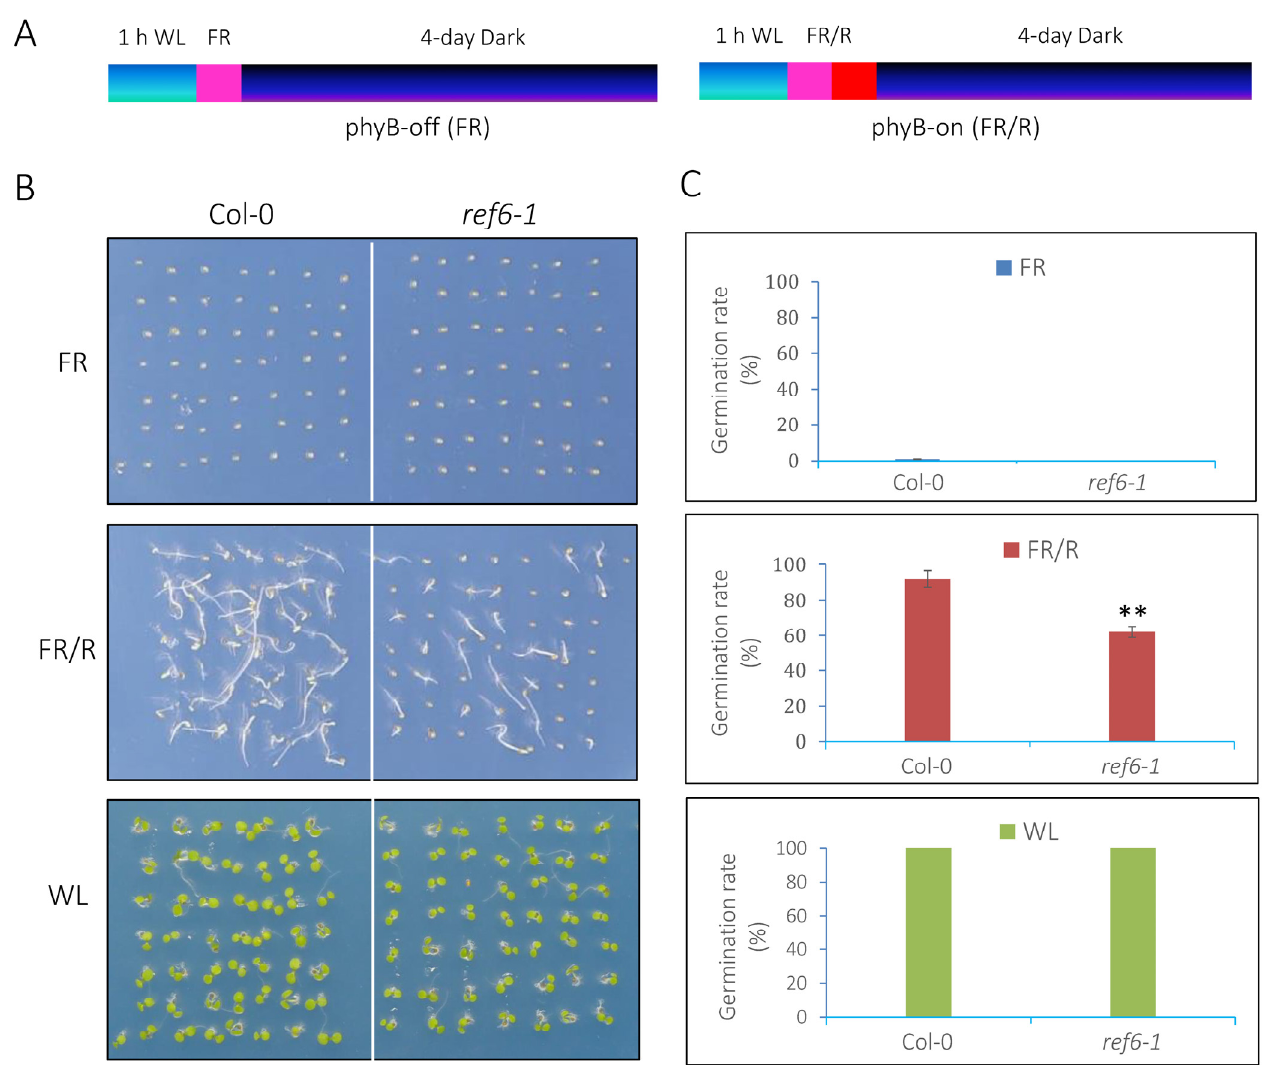
Figure 1. REF6 is a positive regulator of the phyB-dependent seed germination process. ( A ) Diagram displaying the phyB-inactivated (phyB-off, FR) and phyB-activated (phyB-on, FR/R) assays. ( B ) Germination patterns of Col-0 and ref6-1 seeds under FR (phyB-off), FR/R (phyB-on) and WL (80 μ mol m − 2 s − 1 ) conditions. ( C ) Statistical analysis of the germination rates of Col-0 and ref6-1 seeds under FR, FR/R and WL conditions. Asterisks indicate significant differences (** p < 0.01, Student’s t -test). The experiments were performed in triplicate, and 50 seeds were scored for each sample.